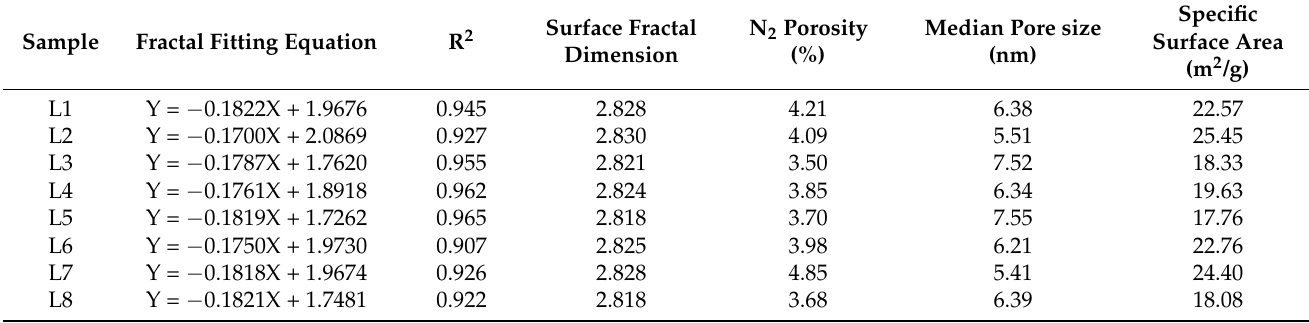
Table 3. Measurement of the physical parameters of deep shale by nitrogen